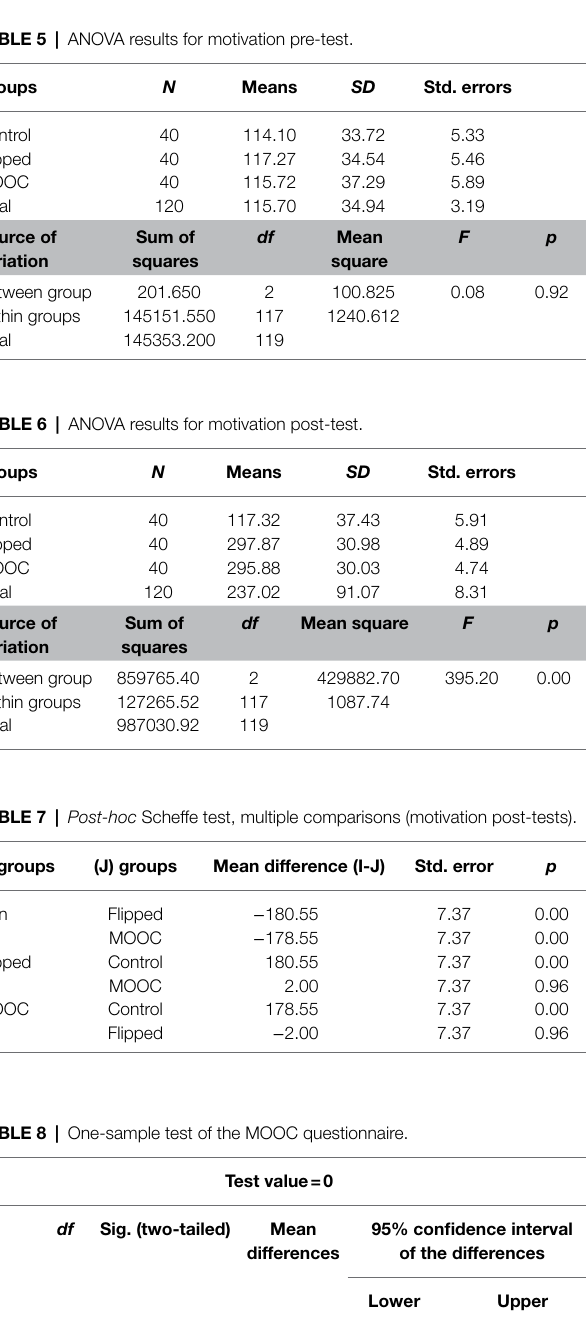
TABLE 5 | ANOVA results for motivation pre-test. Groups